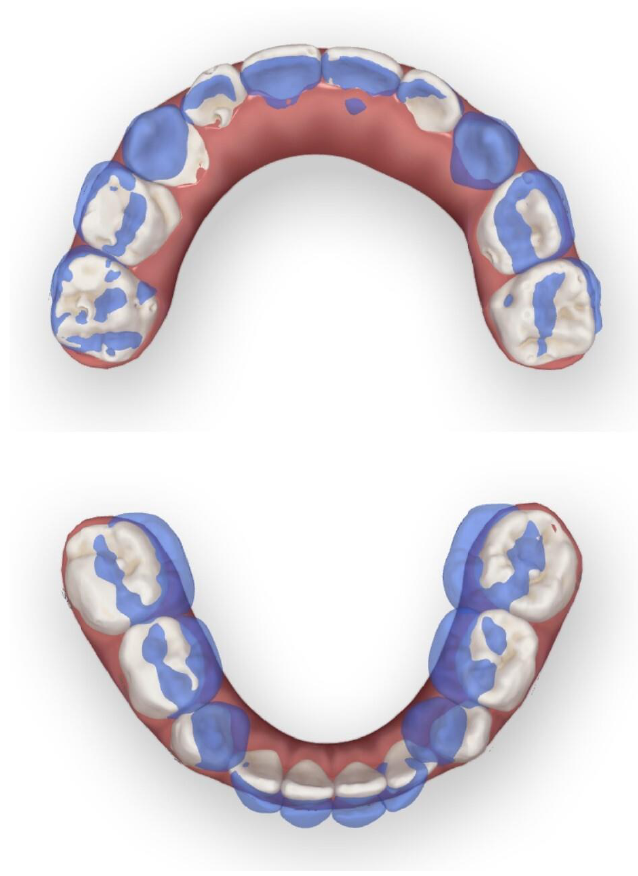
Figure 19. Initial and final model overlay contrast.